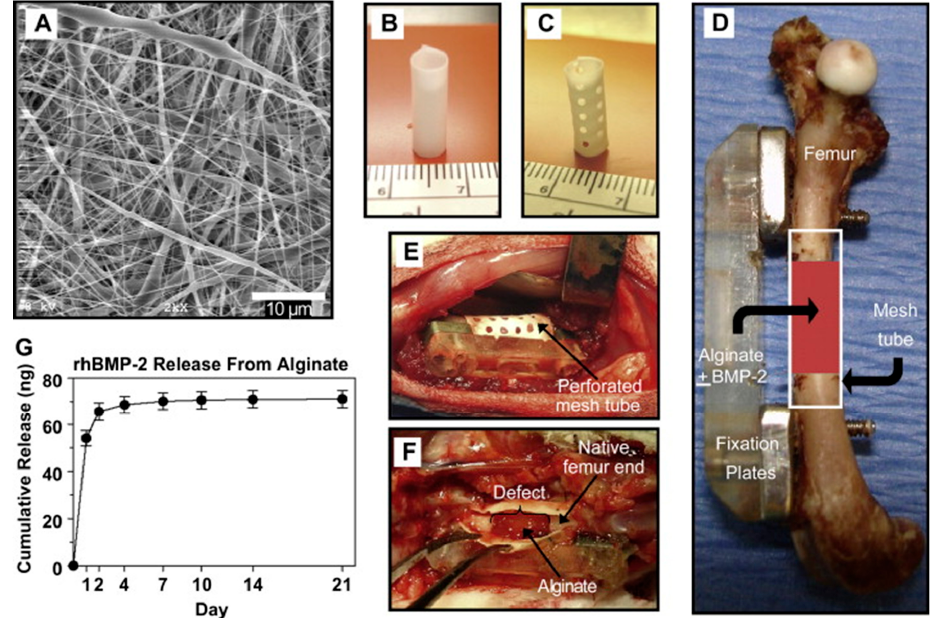
Figure 6. ( A ) SEM images of electrospun nanofiber mesh; ( B ) tubular implant without